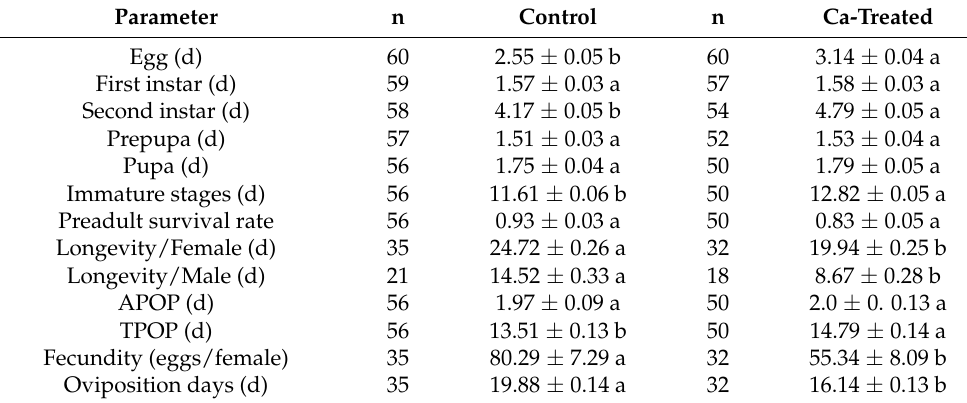
Table 1. Developmental duration, survival, and reproduction of Frankliniella occidentalis fed on control and Ca-treated kidney bean